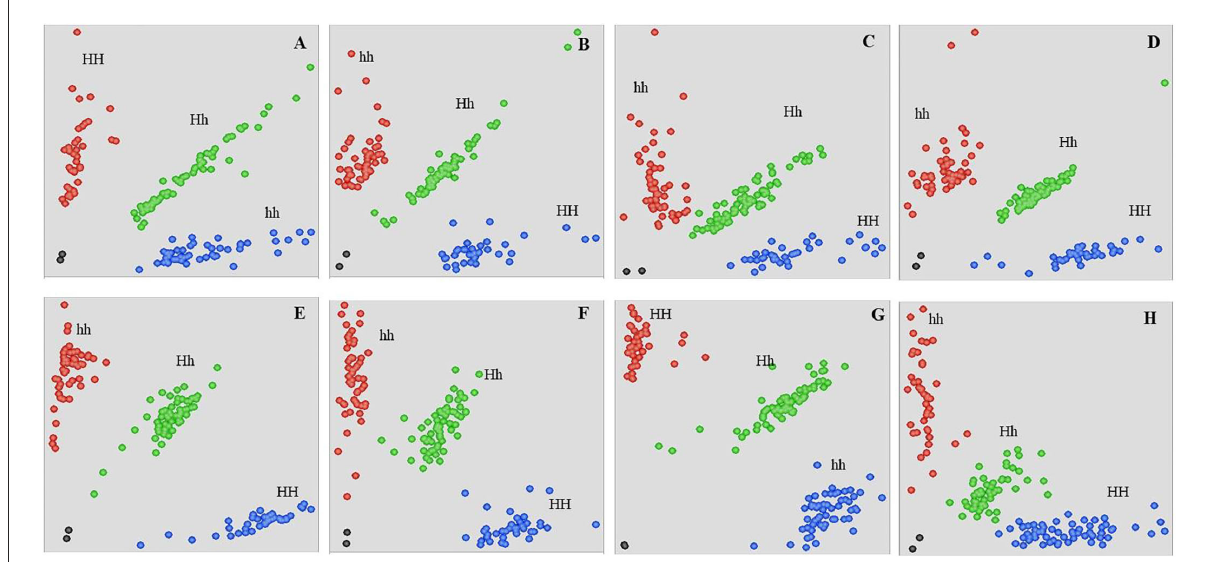
FIGURE4 Genotyping of HP111 × HLP36 derived 160 F 2 individuals using the KASP assay. Scatter plots for KASP assays show clustering of individual plants on the X - (FAM) and Y - (HEX) axes. Blue and red dots represent the homozygous plants, and green dots represent the heterozygous plants. Black dots represent the NTC (non-template control). HH, Homozygous for hulled parent SNP; hh, Homozygous for hull-less parent SNP; Hh, Heterozygous; (A) Cp_2514080; (B) Cp_2698798, (C) Cp_2944813, (D) Cp_3041082, (E) Cp_3197242, (F) Cp_3405355, (G) Cp_3430407, (H)